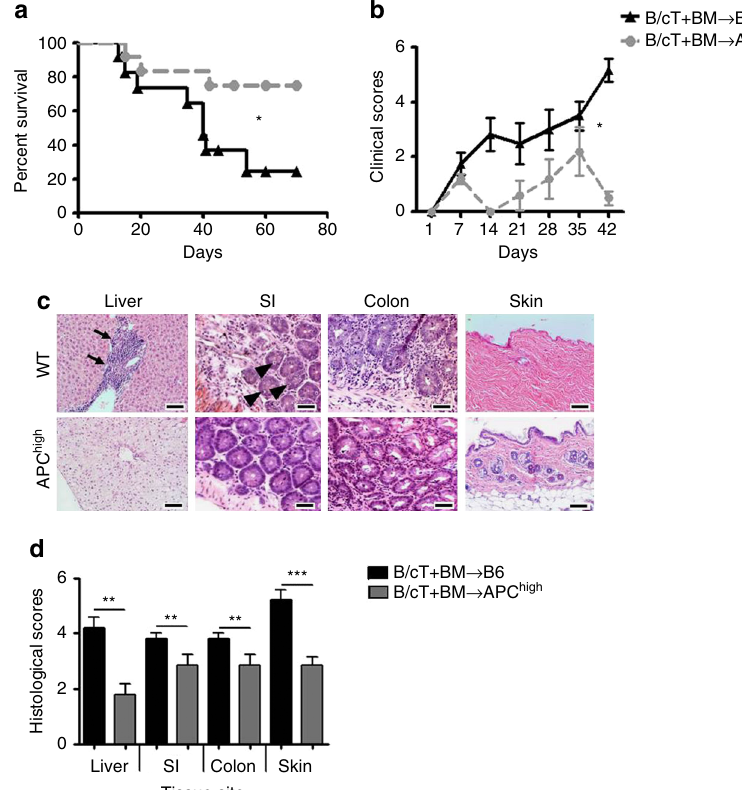
Fig. 1 aPC ameliorates murine GvHD. a , b Recipient C57BL/6 wild-type (B6) mice or C57BL/6 mice with endogenous high levels of aPC (APC high ) were lethally irradiated (13 Gy) and transplanted with 5 × 10 6 whole-bone marrow ( BM ) and 2 × 10 6 T-cells from donor BALB/c mice (B/cT + BM). Recipient mice were monitored for survival ( a Kaplan – Meier curve) and physical parameters (including weight loss, mobility, hunched posture, ruf fl ed fur, and skin integrity), yielding a composite clinical score b ; pooled data from three independent experiments each with four recipient mice per genotype. c , d Photomicrographs ( c ) depicting typical morphology in liver (note lymphocyte in fi ltration, arrow ), small intestine (SI, note apoptotic bodies, arrow head ), colon, and skin (note for example loss of hair follicles and epidermic atrophy) and bar graph ( d ) summarizing histological disease scores. Mean value ± SEM of six B6 recipient and six APC high -recipient mice d ; haematoxylin and eosin stained sections ( c size bar: 50 µ m); *P < 0.05, ** P < 0.01, *** P < 0.001 ( a log-rank test; b ANOVA; d t